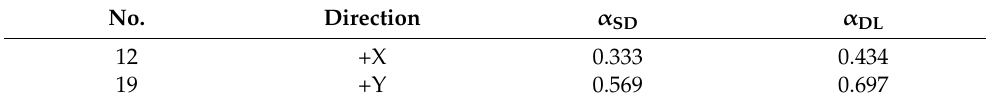
Figure 15. 3D view of damage for the most significant pushover analysis: ( a ) in x-direction; ( b ) in y- direction. Table 4. Values of vulnerability index α for the most significant analysis in the x and y direction.